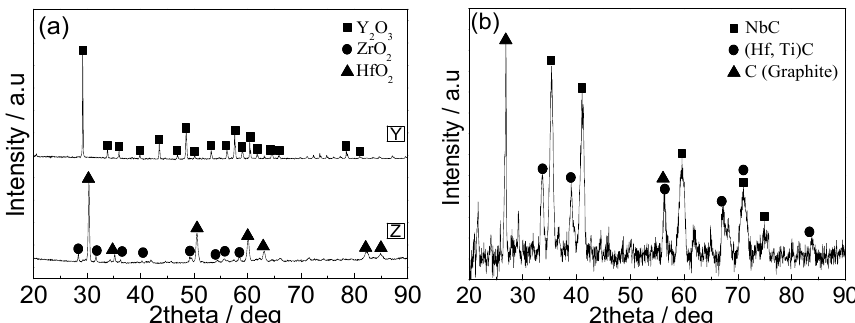
Figure 5. XRD patterns of the lateral surface of the re-melted alloy: ( a ) Y and Z samples in a vacuum